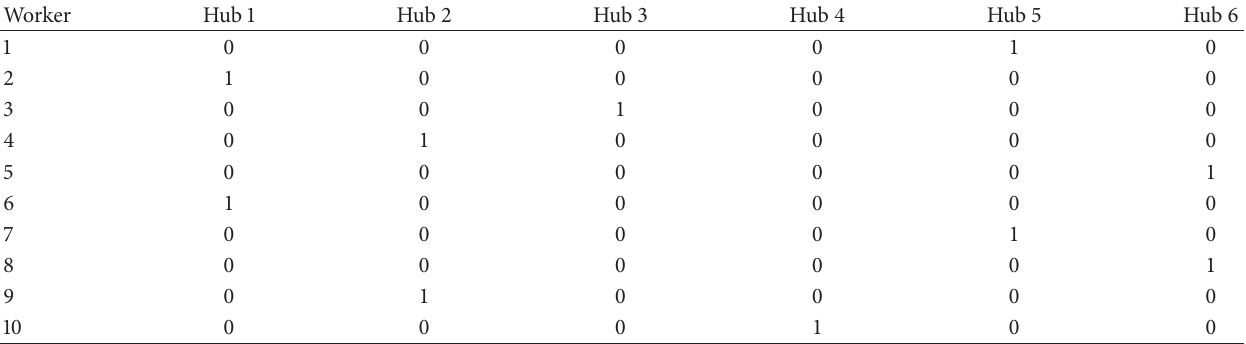
Table 9: The adjusted worker-to-hub allocation plan.